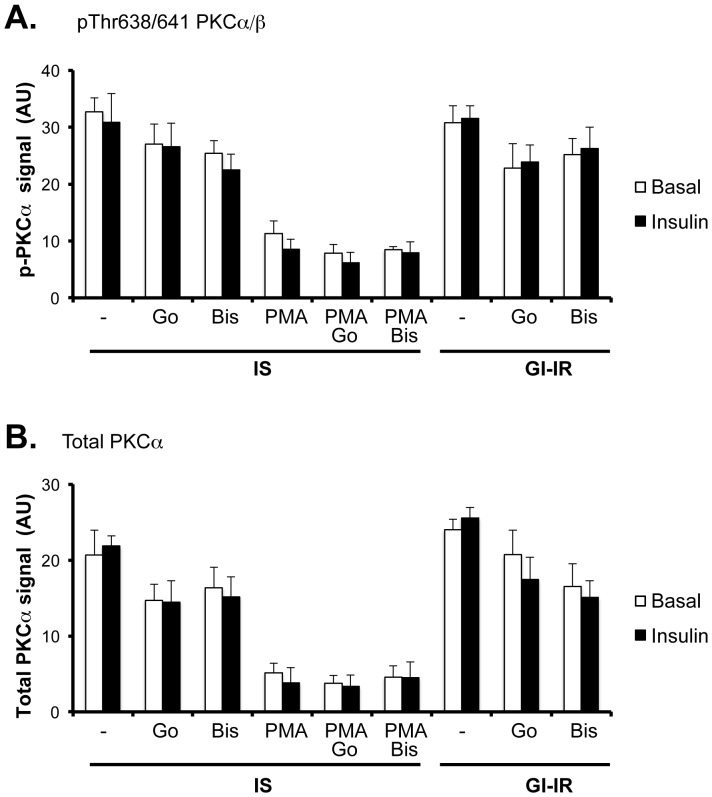
Phosphorylated PKCalpha and total PKCalpha are not altered by hyperglycemia-induced insulin resistance.Adipocytes were preincubated for 18 h in 5 mM glucose (IS) or in 25 mM glucose+0.6 nM insulin (GI-IR). During the last 2 hours cells were exposed to either vehicle control or PMA (1 mM), or during the last hour with Go-6976 (1 mM, Go) or bis-indolylmaleimide (1 mM, Bis). Acute insulin stimulation (black bars) or non-stimulation (white bars) were performed for 15 min with or without 100 nM insulin. Cells were lysed, proteins extracted and subjected to western blotting with antibodies to either phosphorylated pThr638/641 PKCalpha/beta (A) or to Total PKCalpha (B). Quantification was determined as described in Methods. The graph data represents means +/− SE of 6 observations.